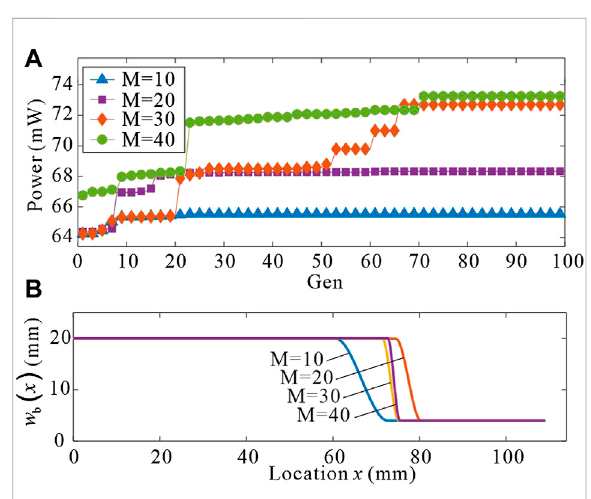
FIGURE 6 (A) Convergence of the objective function in terms of the number of iterations for different operating points M. (B) Optimal beam model for different operating points